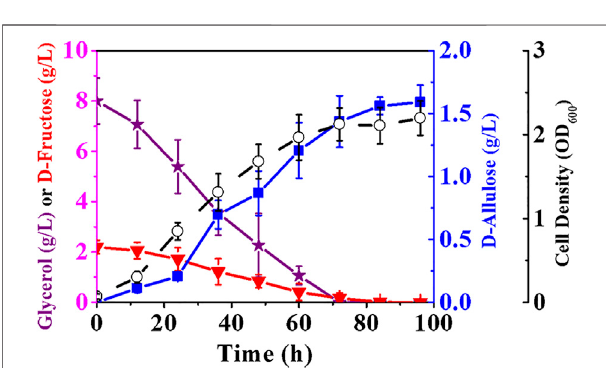
FIGURE 7 | Production of D-allulose in minimal medium with air-limited condition. E. coli ( alsE , a6PP , ptsG - F , mak , pckA , Δ fruA , Δ pfkA , Δ pfkB ) was culturedinM9minimalmediumwith2.20 g/LD-fructoseand8.00 g/Lglycerol at 37 ° C. Error bars, SD , n = 3